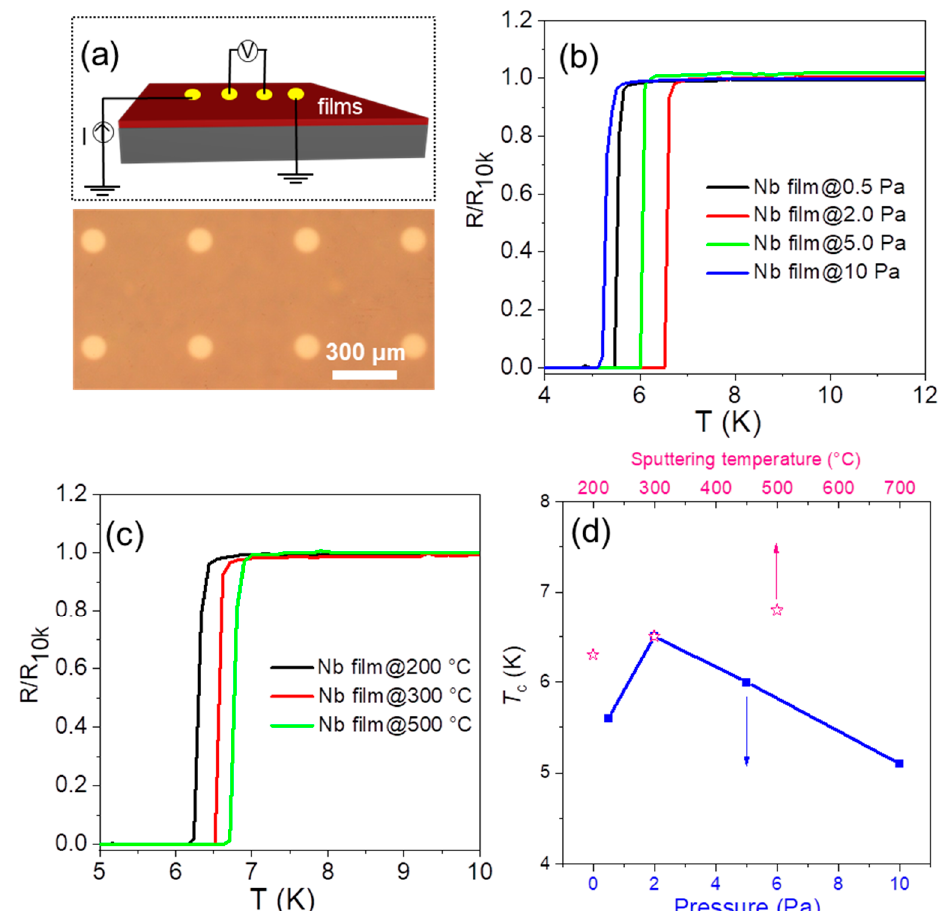
Figure 2. ( a ) A schematic illustration (top) and an optical image (bottom) of the four-probe contact configuration used in the transport experiments; superconductivity of Nb films at ( b ) different sputtering pressures (sputtering temperature: 300 °C) and ( c ) different sputtering temperatures (sputtering pressure: 2 Pa); ( d ) the T c of NbSe 2 films at different sputtering pressures (sputtering temperature: 300 °C) and temperatures (sputtering pressure: 2 Pa).